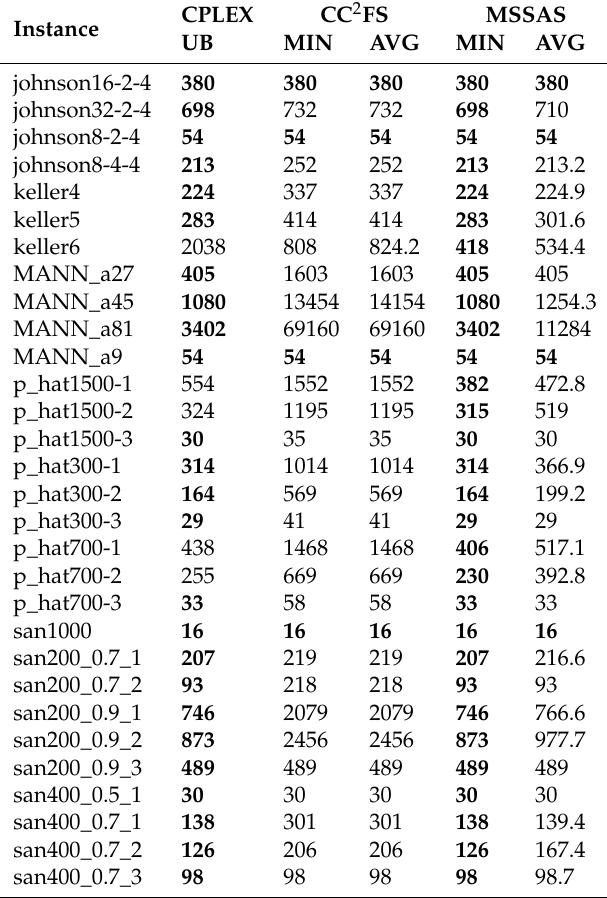
Table 3. Experimental results of CPLEX, CC 2 FS and MSSAS